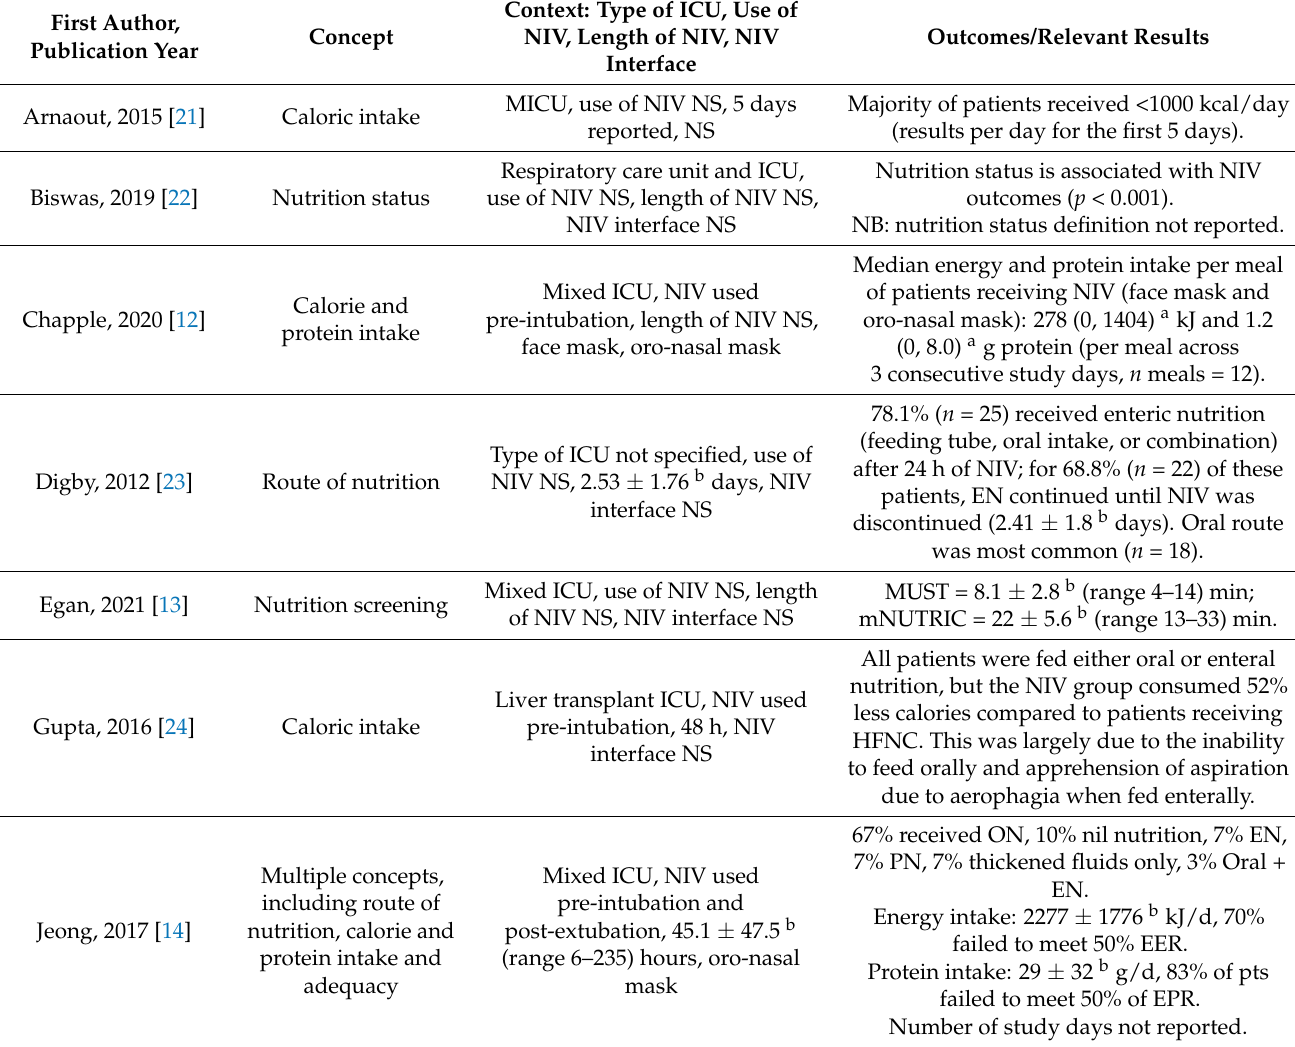
Table 3. Concept, context, and relevant results of included